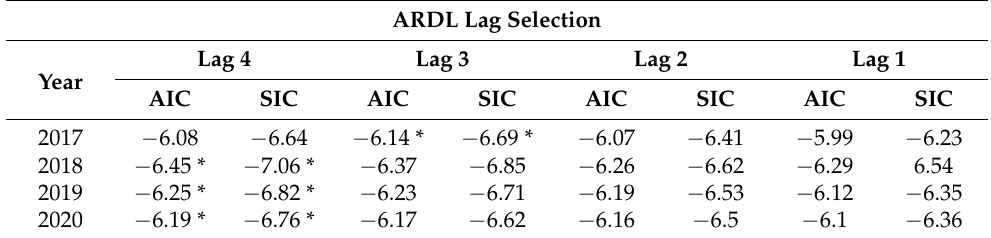
Table 2. Lag selection using Akaike Info Criteria (AIC) or Schwarz Info Criterion (SIC).